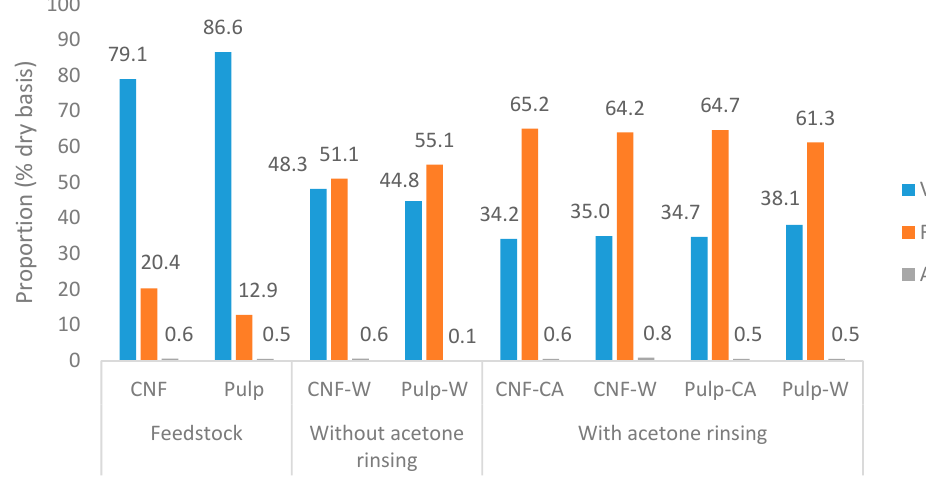
Figure 3. Proximate composition of feedstocks and hydrochars.